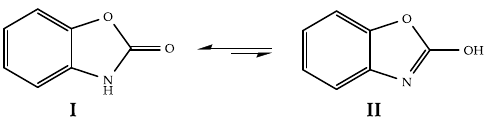
Figure 1. Amide tautomer of 2-benzoxazolinone ( I ) and the corresponding enol form ( II